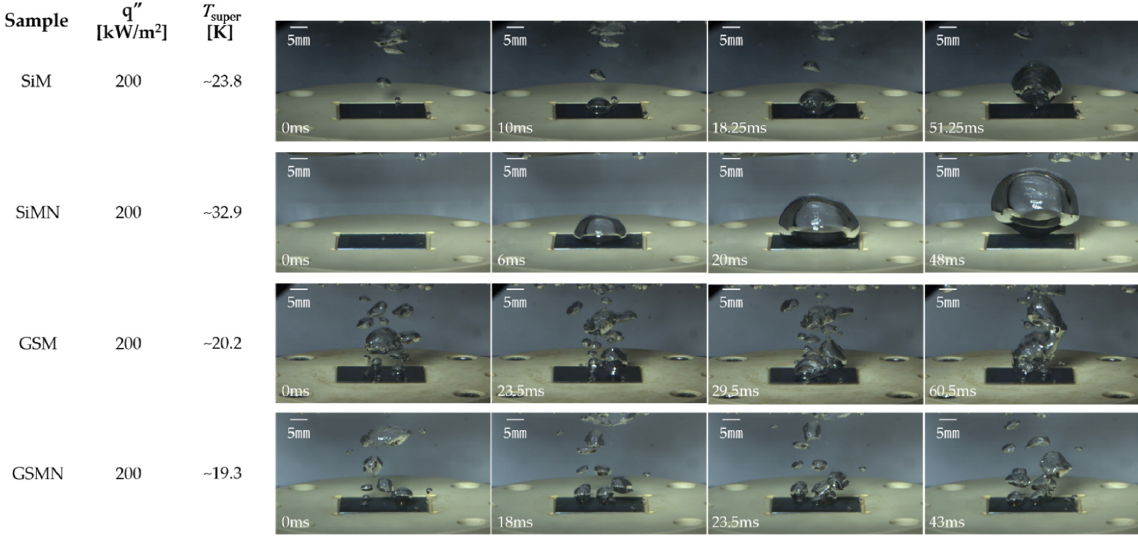
Figure 9. Bubble images on the SiM, SiMN, GSM, and GSMN. SiM, SiMN have less nucleate site density, but GSM, GSMN have more nucleate site density than SiM, SiMN.